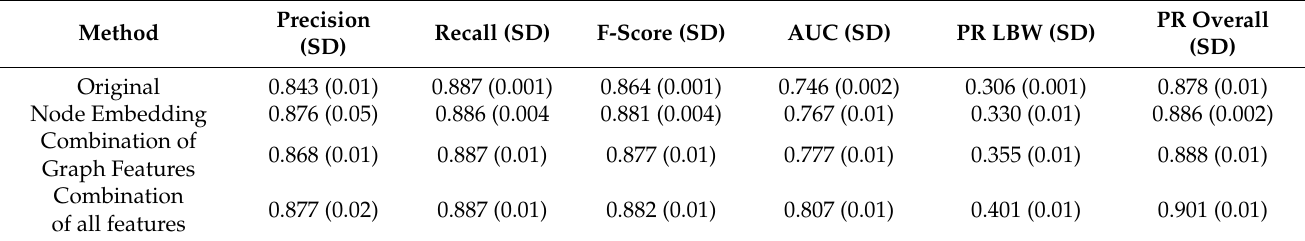
Table 3. Experiments performed using a random forest classifier.